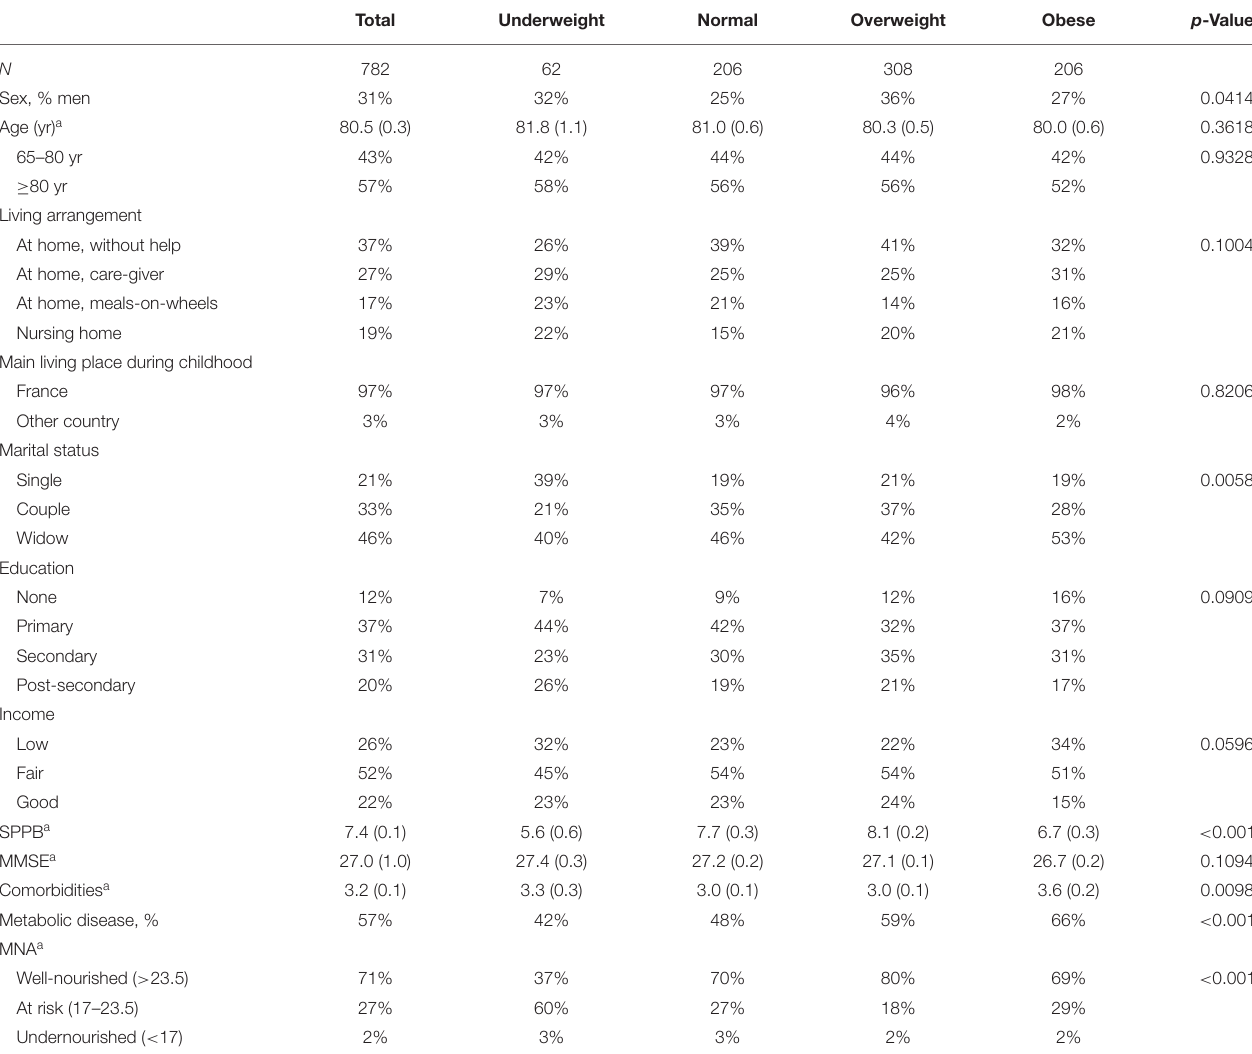
TABLE 1 | Characteristics of the population according to BMI status (underweight: BMI < 21; normal: 21 ≥ BMI < 25; overweight: 25 ≥ BMI < 30; obese: BMI ≥ 30). Total Underweight Normal Overweight Obese p -Value